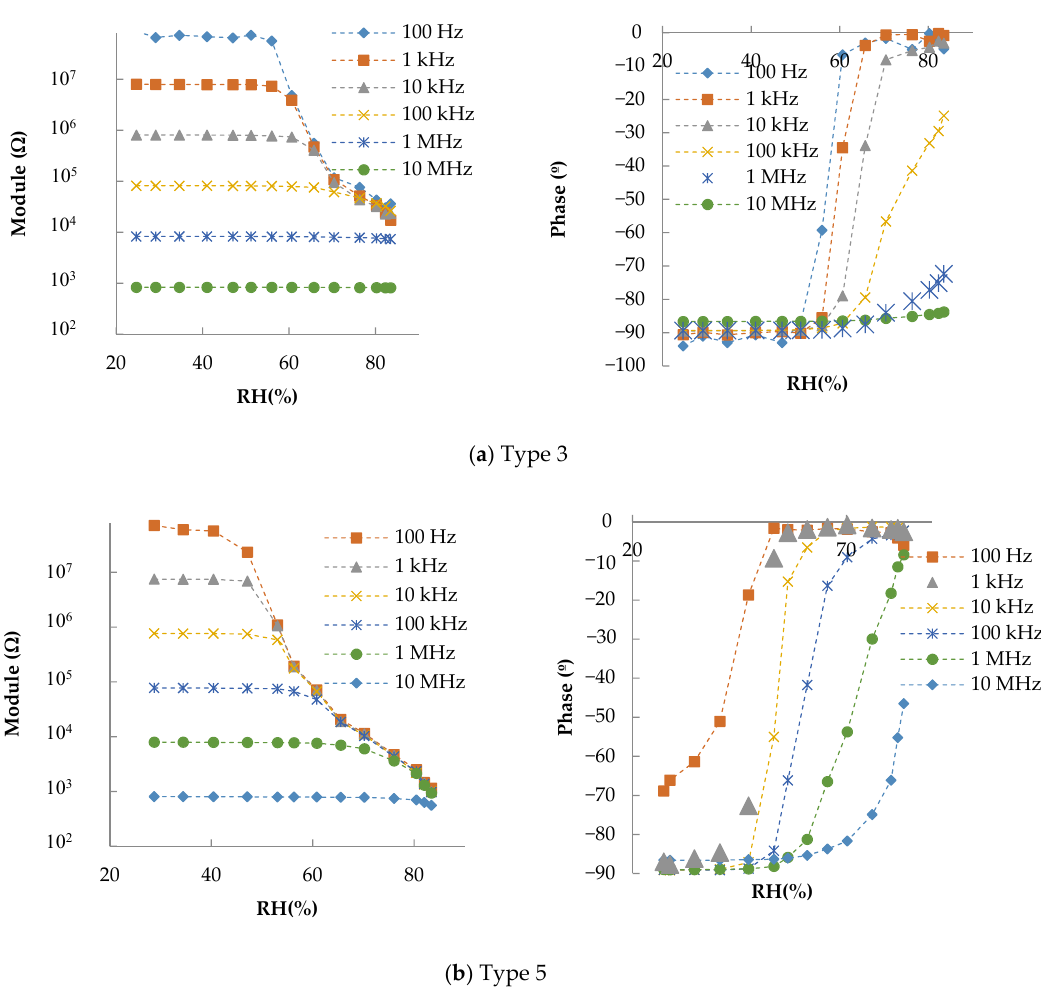
Figure A2. Impedance response towards RH at 40 °C for different operating frequencies for sensors with interspacing of 400 µm: ( a ) type 3 and ( b ) type 5. Module is depicted in the left column and phase in the right one.